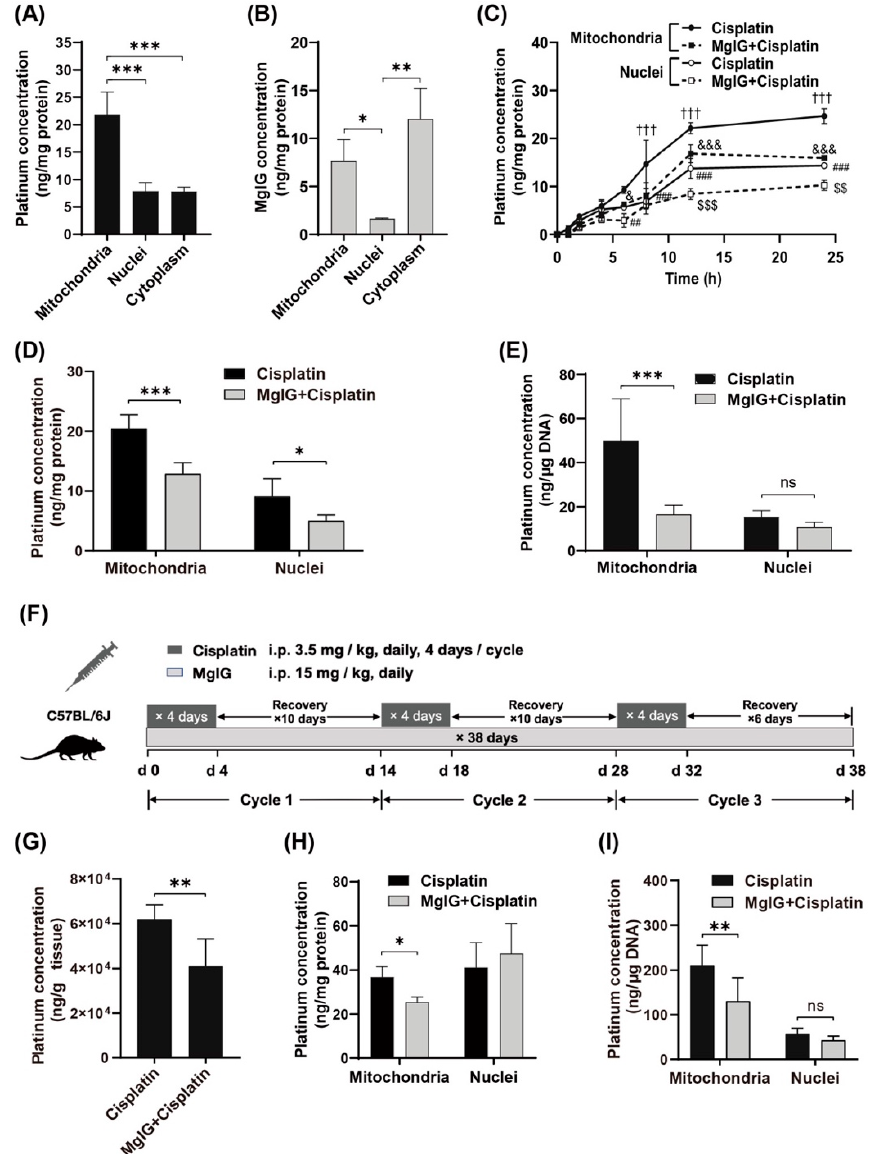
Figure 1. MgIG reduces the concentration of cisplatin in mitochondria and target-binding amount to mtDNA. ( A ) The subcellular distribution of platinum in HK-2 cells, n = 5. Cisplatin tends to accumulate in mitochondria. ( B ) The subcellular distribution of MgIG in HK-2 cells, n = 3. MgIG amount in mitochondria is higher than that in nuclei. ( C ) The concentration–time process of platinum in mitochondria and nuclei of HK-2 cells, n = 3. ( D ) The subcellular distribution of platinum after MgIG combination in HK-2 cells for 24 h, n = 5. Co-treatment with MgIG reduces the accumulation of cisplatin in mitochondria. ( E ) The effect of MgIG on the concentration of platinum bound to DNA, n = 5. MgIG specifically reduces platinum–mtDNA level. ( F ) Flow chart of administration to mice in the designated groups. ( G ) The platinum concentration in kidneys, n = 6. Combination with MgIG reduced platinum concentration in kidneys. ( H , I ) The concentration of platinum and its binding amount to DNA in mitochondria and nuclei of kidneys. MgIG reduced the concentration of platinum in mitochondria and its binding to DNA in kidneys. The data are presented as the mean ± SD. * p < 0.05, ** p < 0.01, *** p < 0.001 , ns indicates no significant difference; ††† p < 0.001 the Mitochondria–cisplatin group versus the Mitochondria–MgIG + cisplatin group; & p < 0.05, &&& p < 0.001 the Nuclei–MgIG + cisplatin group versus the Mitochondria–MgIG + cisplatin group; ## p < 0.01, ### p < 0.001 the Mitochondria–cisplatin group versus the Mitochondria–cisplatin group; and $$ p < 0.01, $$$ p < 0.001 the Nuclei–cisplatin- group versus the Nuclei–MgIG + cisplatin